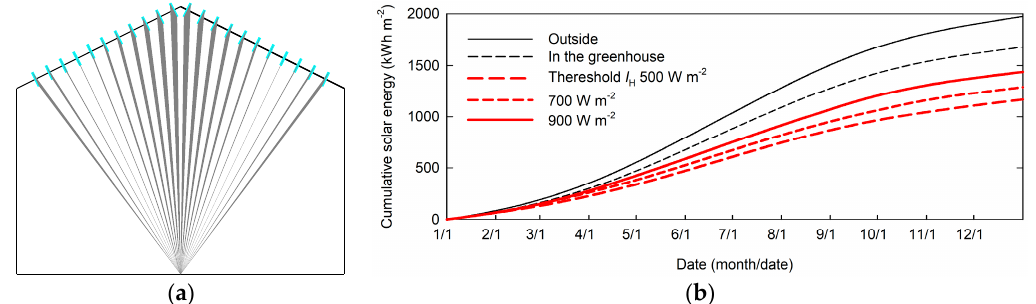
Figure 15. Estimated cumulative solar energy in the north–south oriented greenhouse equipped with a PV blind entirely covering the roof: ( a ) the shading zones by the PV blinds were painted in gray assuming that the sunlight transmittance of the PV module at θ = 90° is 0; ( b ) the thresholds I H s were chosen at the three levels of 500, 700, and 900 W m − 2 . The transmittance of the greenhouse glazing and the blind at parallel and perpendicular positions were assumed as 85%, 60%, and 92% (8% is PV shadow as depicted in ( a )), respectively. Cloudless sky with atmospheric transmittance of 0.65 was assumed. For comparison, solar energy outside the greenhouse and inside the greenhouse without PV blinds (greenhouse frames were omitted) are also presented.